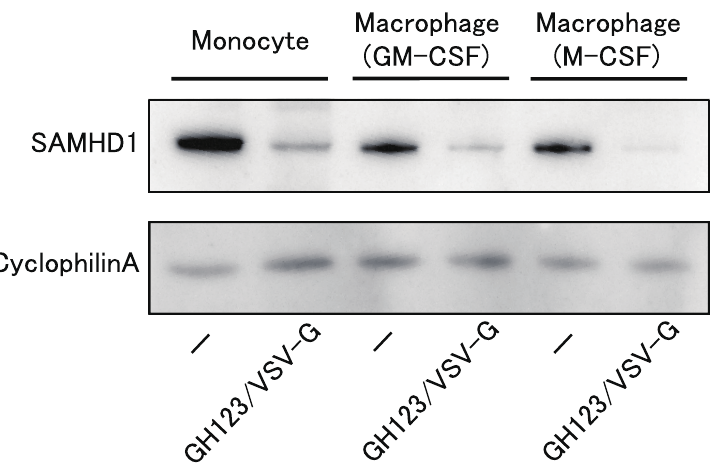
Figure 6. Western blot analysis of SAMHD1 in undifferentiated monocytes and macrophages. Monocytes were differentiated into macrophages for 6 days in the presence of GM-CSF or M-CSF. Macrophages or monocytes were treated with or without VSV-G-pseudotyped and Env- defective HIV-2 particles (GH123/VSV-G), and harvested. Whole-cell extracts were separated on SDS-PAGE and analyzed by western blot using the indicated antibodies. Presented data are representative of two independent